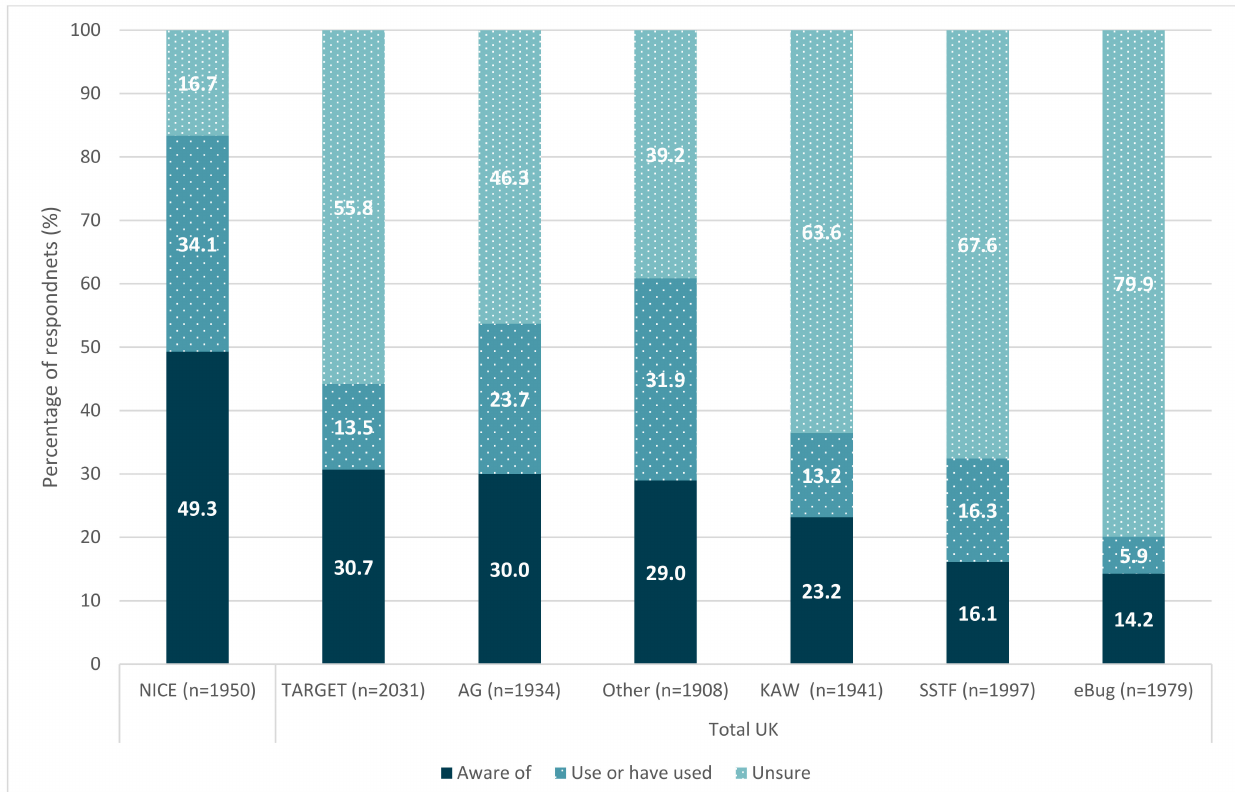
Figure 3. Awareness of campaigns in the UK; NAP ( n = 2060), EAAD ( n = 2070) and WAAW ( n = 2054).